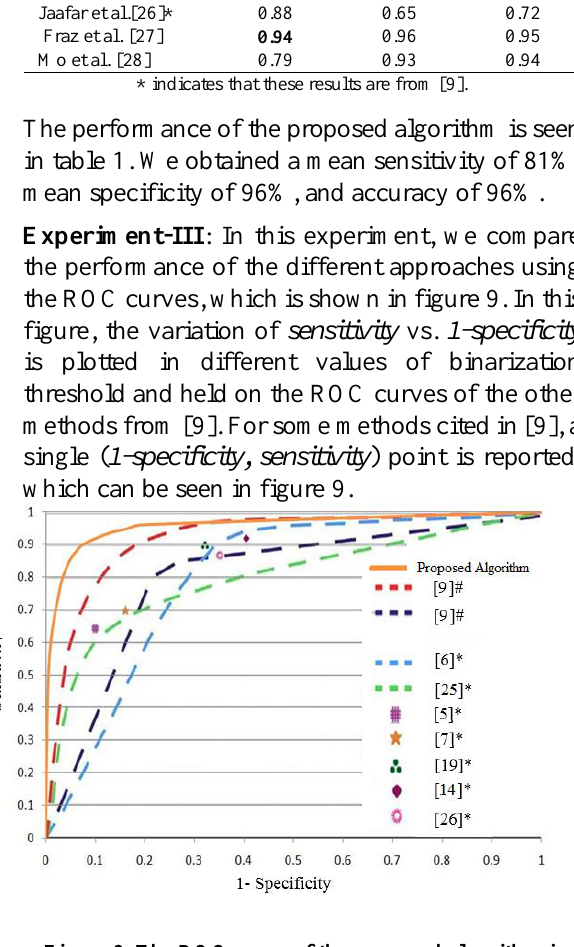
Figure 9. The ROC curve of the proposed algorithm in comparison with others from